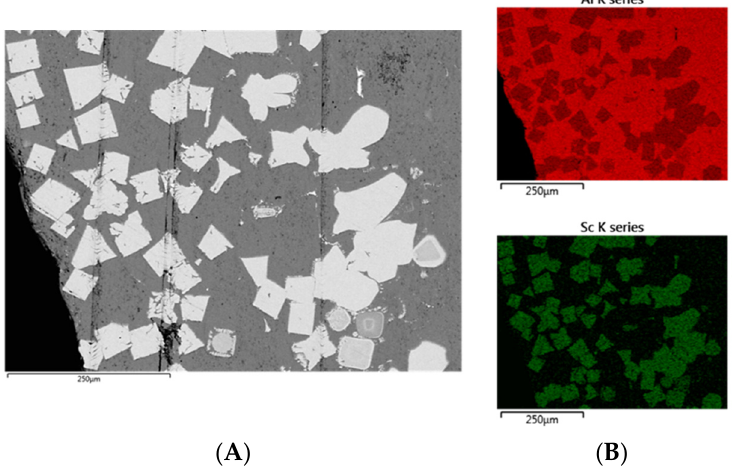
Figure 3. ( A ) SEM micrograph of the metal product obtained with the TiB 2 cathode, and ( B ) EDS